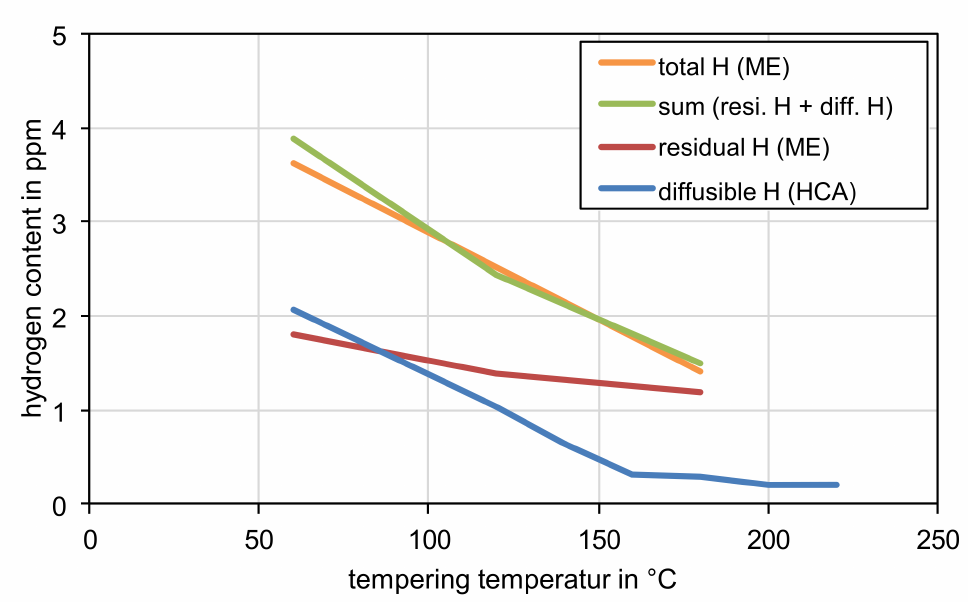
Figure 9. Correlation between different hydrogen analysis methods; melt extraction (ME), hydrogen collecting analysis